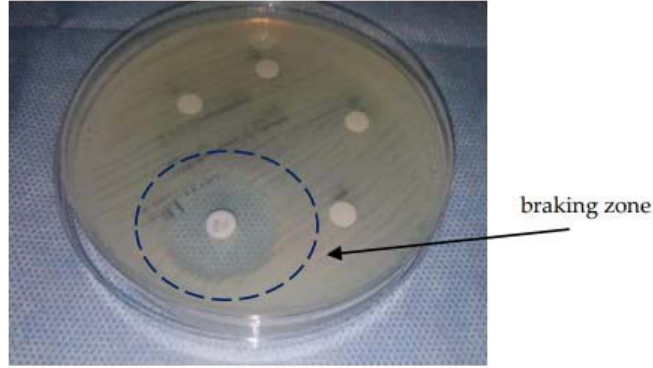
Figure 5. Bacteriostatic effect of a control contains antibiotic ‐ braking zone visualized.